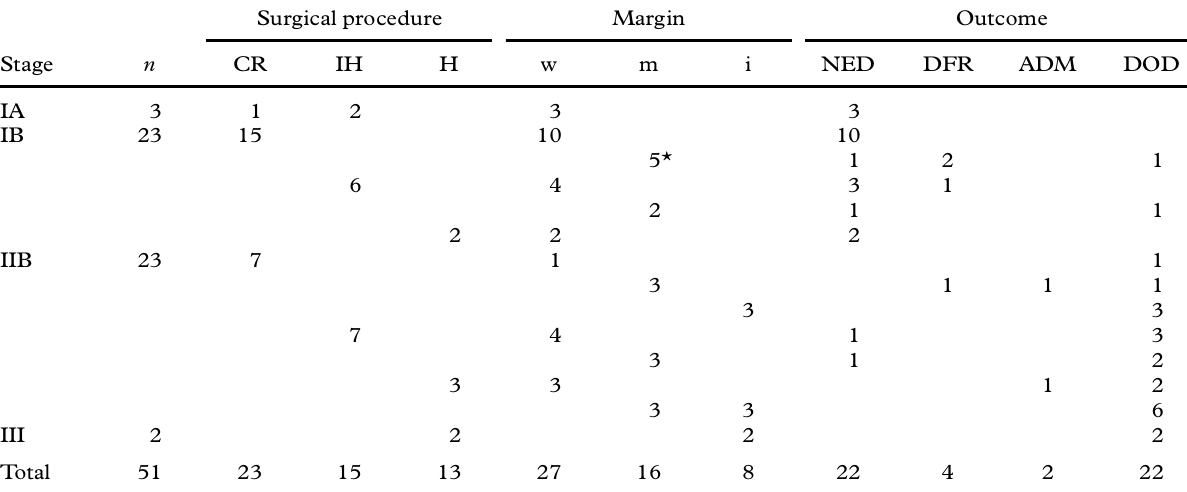
Table 4. Oncologic outcome Surgical procedure Margin Outcome